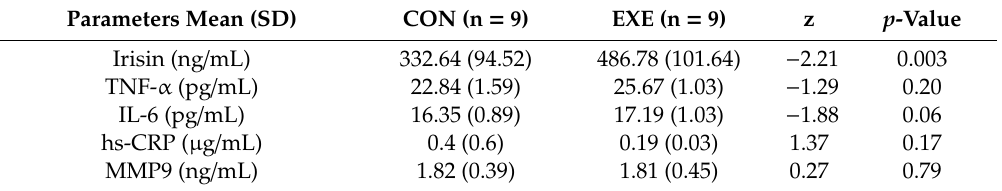
Table 3. Description of the irisin and pro-inflammatory cytokines levels between the control and exercise